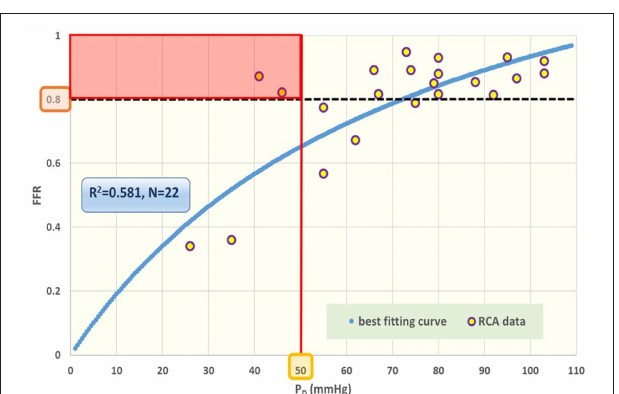
FIGURE 8 | Fractional flow reserve ( FFR ) against post-stenotic mean pressure ( P D ). Data points for cardiac patients ( N 22) with right coronary artery (RCA) = stenosis. The blue curve refers to the best fitting regression ( R 2 0.581), = predicted on the basis of the theoretically derived formula FFR = P D /(c 1 c 2 P D ). The black broken line indicates the traditional cut-off level at + 0.80 for FFR . The various data points near this line can be further characterized by specifying the prevailing P D value. The red line reflects a tentative complementary cut-off for the co-variable P D , assuming that a driving P D below 50 mmHg is inadequate for appropriate perfusion. Acceptance of this criterion implies that the patients within the red rectangular area are in jeopardy. Clearly, any suggested combination of cut-off levels requires future robust evaluation in large patient groups. In the section Discussion, this graph is compared with results obtained from the in silico study ( Figure 3, lower-right).